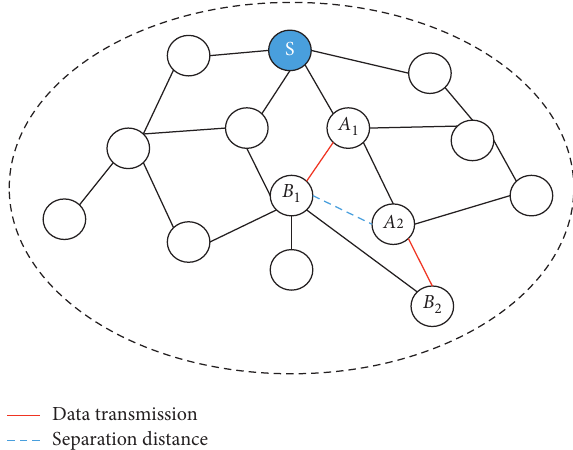
Figure 4: The schematic diagram that I